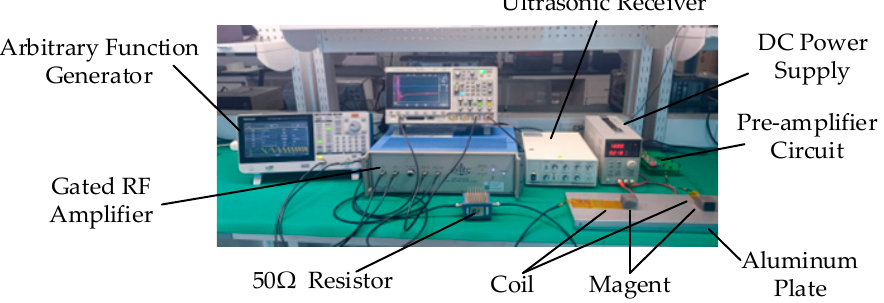
Figure 11. Picture of the experimental system for SPC test.